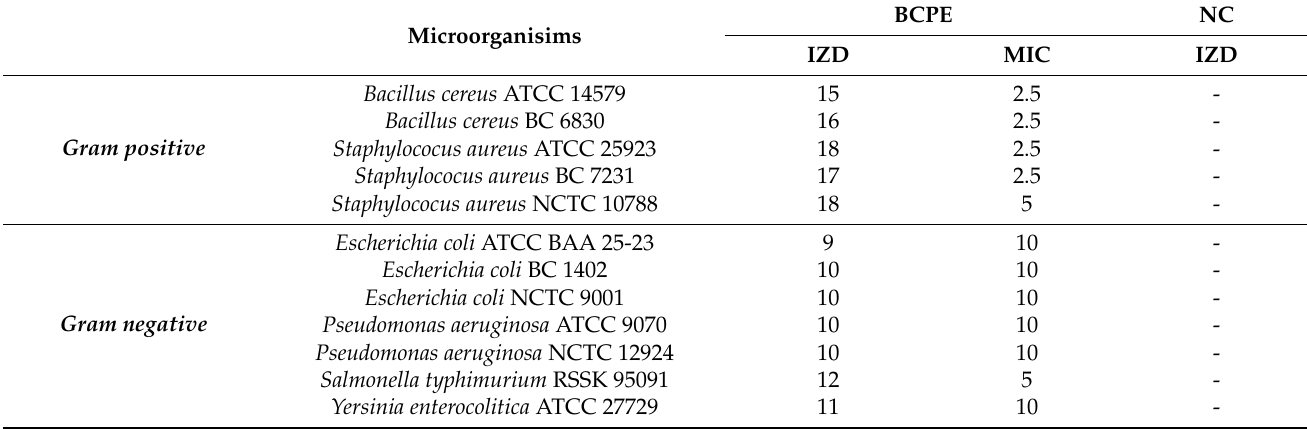
Table 4. In vitro antibacterial activity of BCPE (at a concentration of 20 mg/mL) via agar well diffusion (AWD) method. (Inhibition zone diameter (IZD: mm) and minimum inhibition concentration (MIC— mg/mL). For negative control (NC), 80% DMSO was